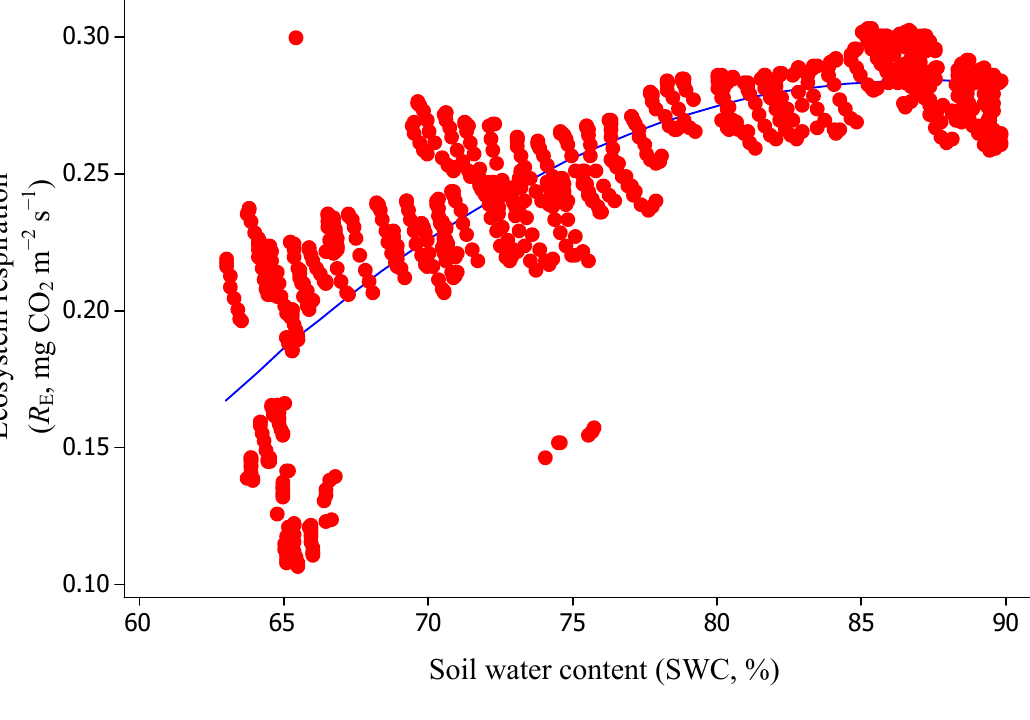
based on Equation (11) for the E